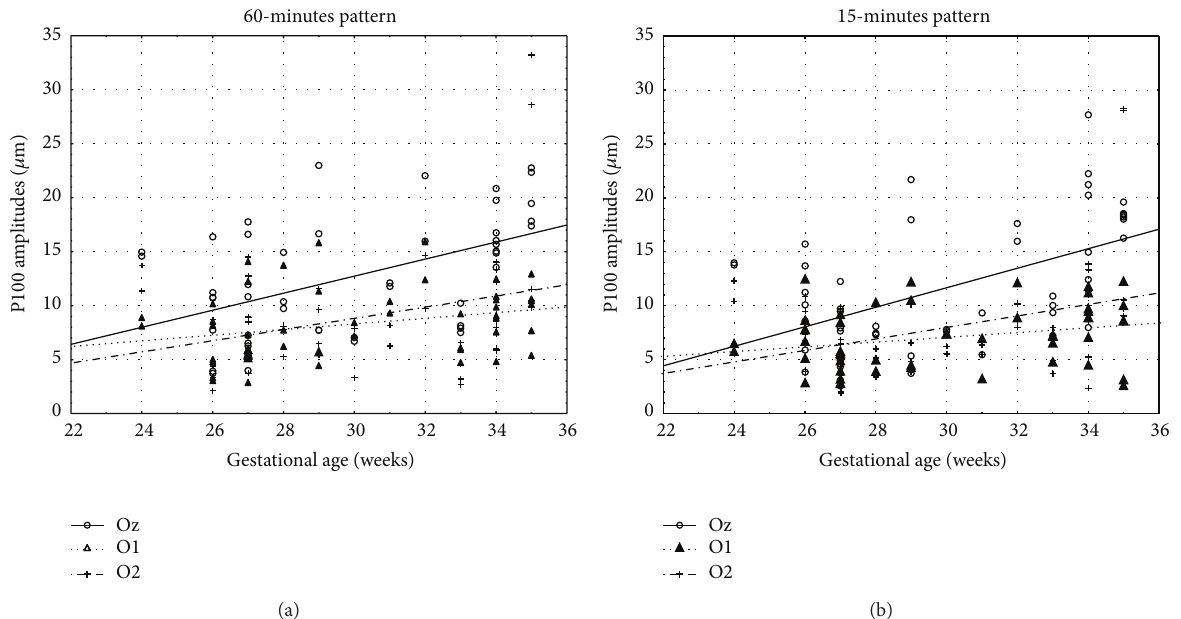
Figure 4: Scatter diagram showing a positive linear correlation between P100 amplitudes ( 𝜇 m) and gestational age (weeks) in 15- and 60- minute pattern stimuli.